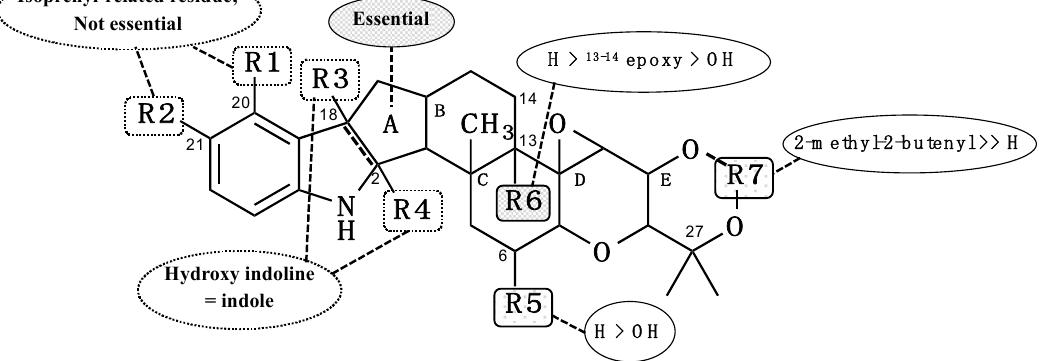
Figure 6. Structure–activity relationships of terpendole congeners for SOAT inhibitory activity.